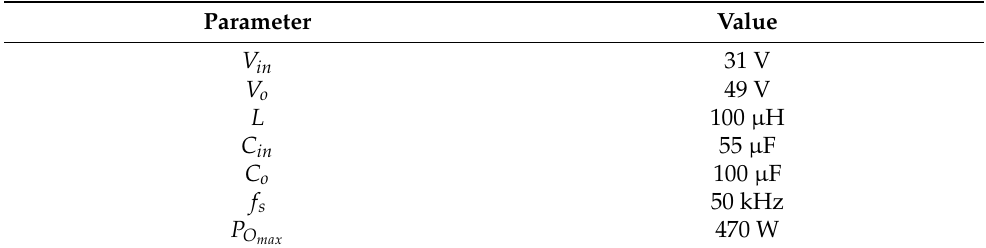
Table 3. Implemented DC/DC Boost converter circuit specifications.